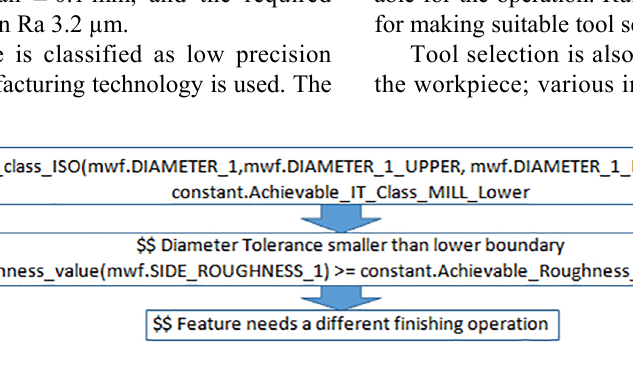
Fig. 6. Decision making rules for technology